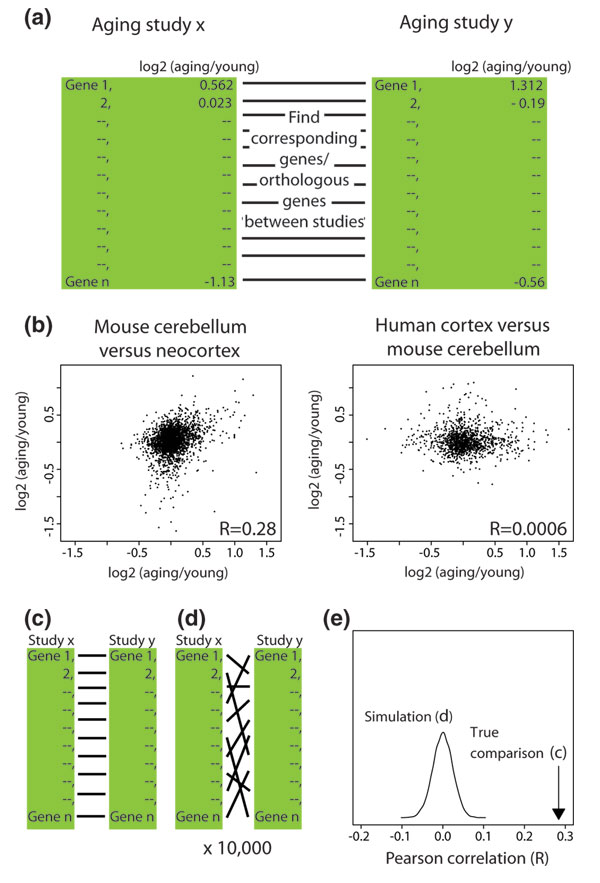
Method for quantifying similarity between gene expression profiles and assessing significance. (a) The aging to young ratio of gene expression is calculated and log-transformed for all genes or orthologous genes present on both of the compared microarrays. Ortholog pairs need to be identified in cross-species comparisons. (b) Two example scatter plots for comparisons of change in gene expression with age. The calculated correlations (Pearson; R) are displayed to the lower right in the plots. (c-e) A distribution of correlations is produced by randomly pairing the genes present on both microarrays 10,000 times and calculating the Pearson correlation for each permutation. The distribution of random correlations (Monte Carlo simulation) is displayed as a density curve in (e). The actual correlation, indicated by an arrow in (e), can then be compared to the random distribution of correlations.